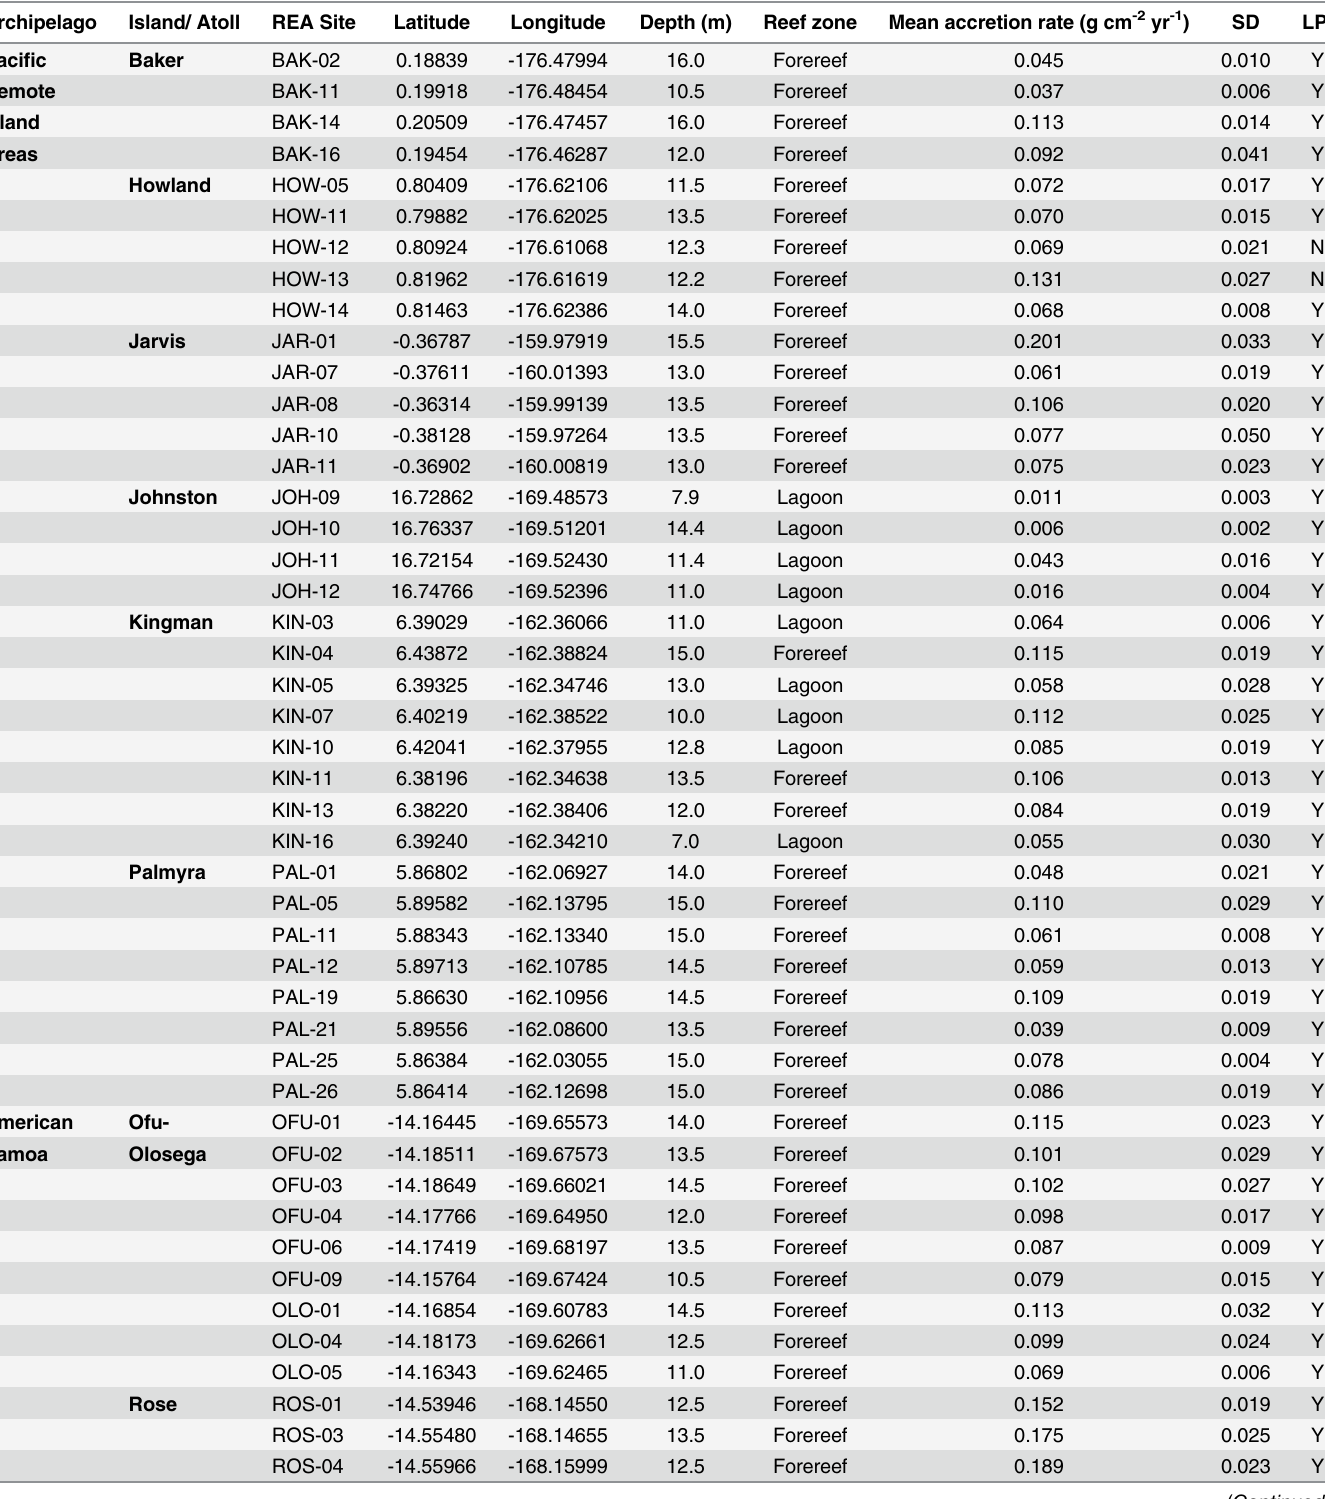
Table 1. Calcification Accretion Unit site locations, depth, reef zone, mean accretion rates, and standard deviation (SD). Availability of benthic cover data from Line-Point-Intercept (LPI) surveys is indicated, Y: yes; N: no.